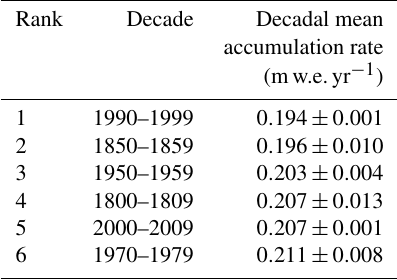
Table 4. Ranking of decades since 1700CE according to lowest mean accumulation. Uncertainties (95% confidence interval) of the mean values are due to uncertainties in the accumulation reconstruc-